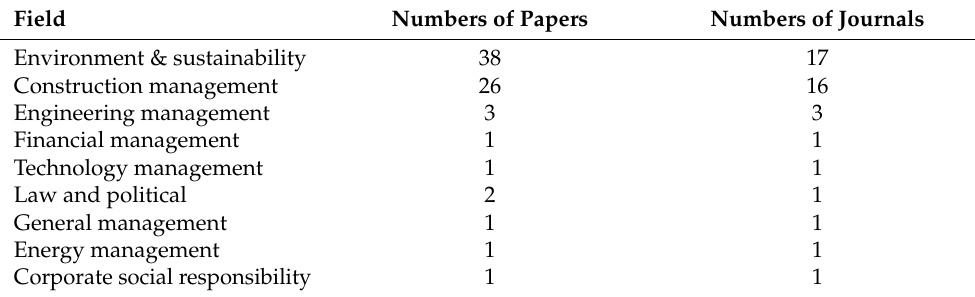
Table 1. Field of research based on journals and